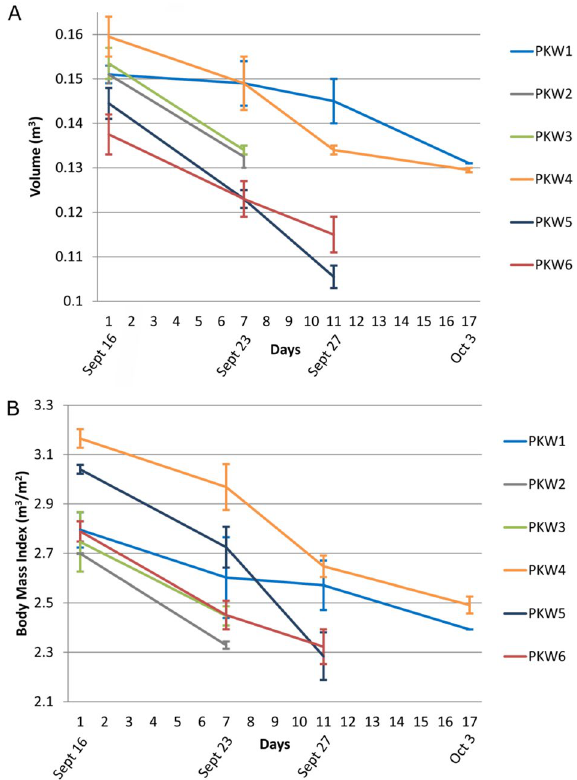
Figure 2. Pygmy killer whale ( A ) volume (m 3 ) ± SD and ( B ) body mass index (BMI; m 3 /m 2 ) ± SD as a function of observation days during a 21-day stranding event that took place from September 13 to October 3, 2019 in the nearshore waters of Ma ʻ alaea Bay, Maui, where Day 1 corresponds to September 16, 2019. Note : UAS measurements were collected over the last 17 days of the stranding event.